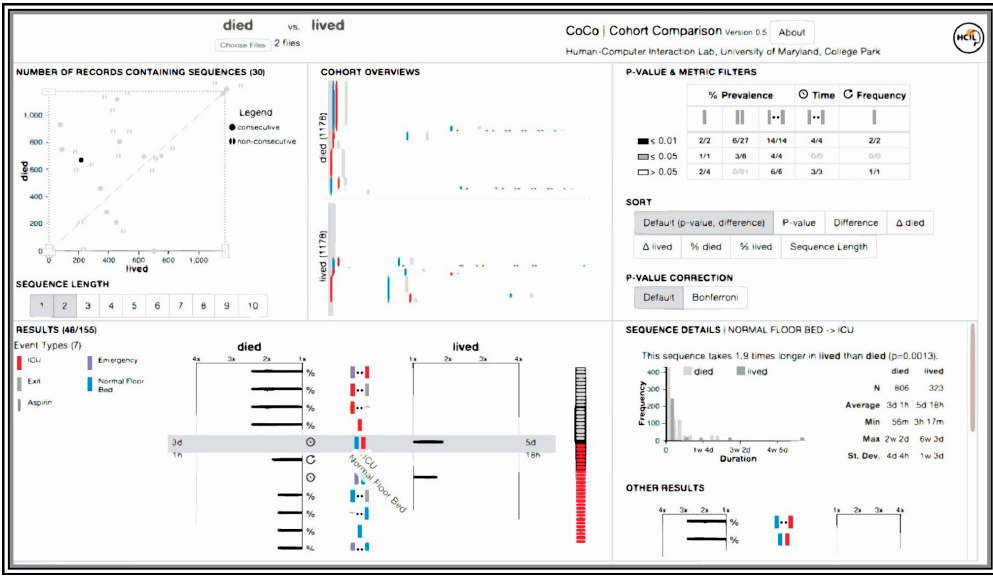
Figure 8. CoCo: Interactive visualization tool for comparing cohorts of event sequences. Source: image courtesy of the University of Maryland Human–Computer Interaction Lab, http://hcil.umd.edu.